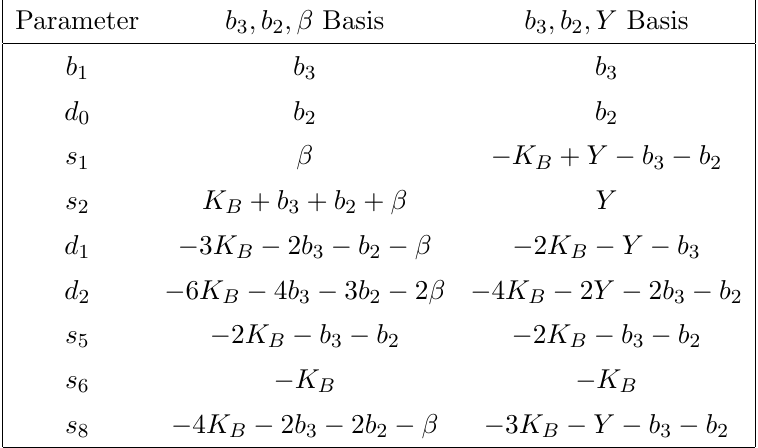
Table 3 . Homology classes for the divisors parameterizing the (SU(3) (cid:2) SU(2) (cid:2) U(1)) = Z 6 Weier- strass model in eq. (3.1), in two